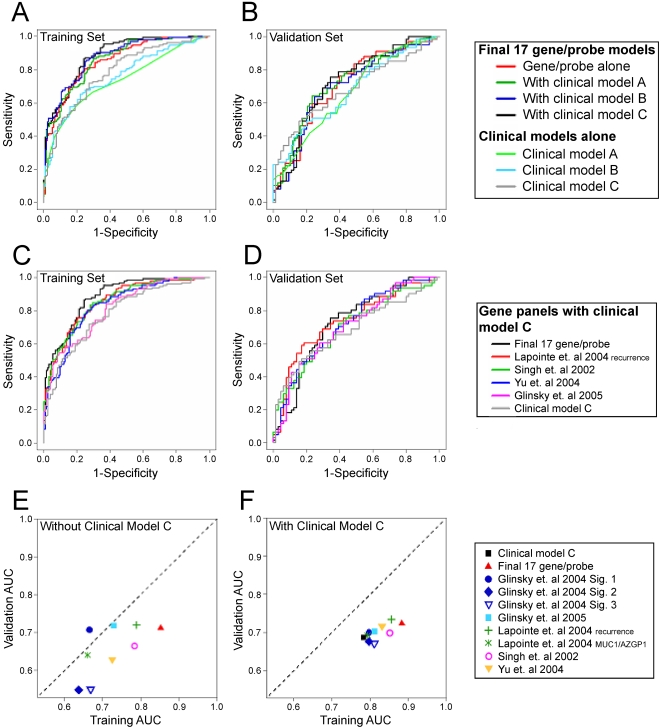
Areas under the curve (AUCs) for three clinical models, the final 17 gene/probe model and the combined clinical probe models.A. The training set AUCs for three clinical models, the final 17 gene/probe model and the combined clinical/17 gene/probe model. B. The validation set AUCs for three clinical models, the final 17 gene/probe model and the combined clinical/17 gene/probe model. C. The training set AUCs of 4 previously reported gene expression models of prostate cancer aggressiveness compared with the clinical model C alone and with the 17 gene/probe model. D. The validation set AUCs of 4 previously reported gene expression models of prostate cancer aggressiveness compared with the clinical model C alone and with the 17 gene/probe model. For an explanation of the clinical models see Table 6. (E and F) A comparison of the training and validation set AUCs for each of the model. E. AUCs of the each of the gene/probe models alone. F. AUCs of each of the gene/probe models with the inclusion of clinical model C.